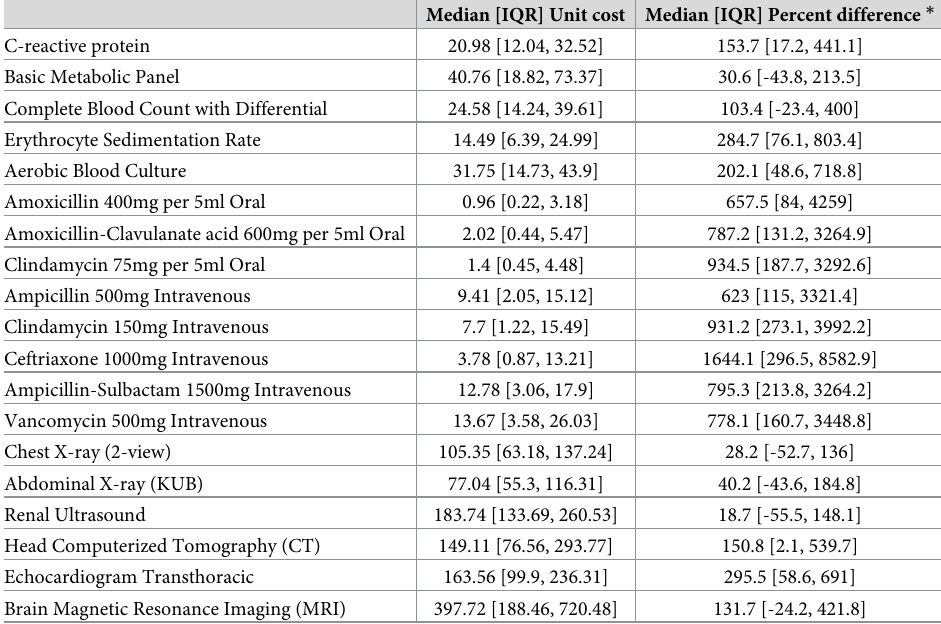
Table 4. Median [interquartile range] unit cost and percent